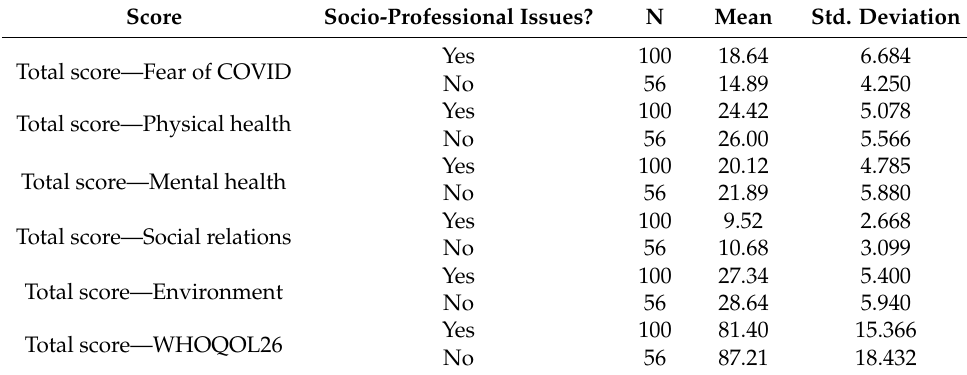
Table 5. Cross-reference between the total scores of participants reporting socio-professional